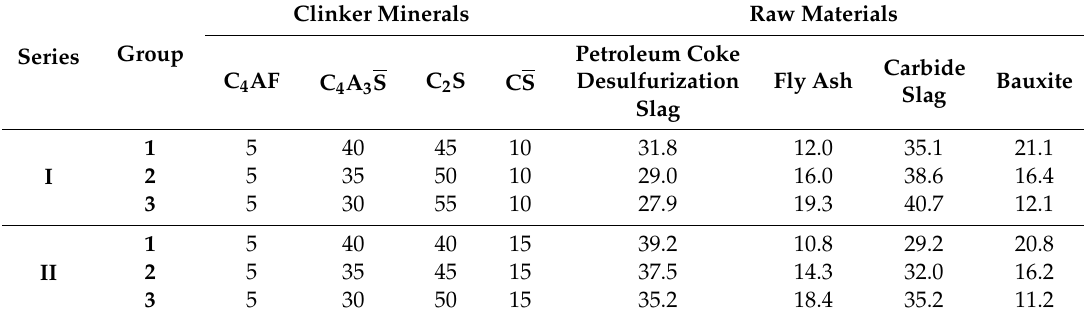
Table 2. Design of the mineral composition of the clinker and the proportion of the raw materials, wt.%. Clinker Series Group